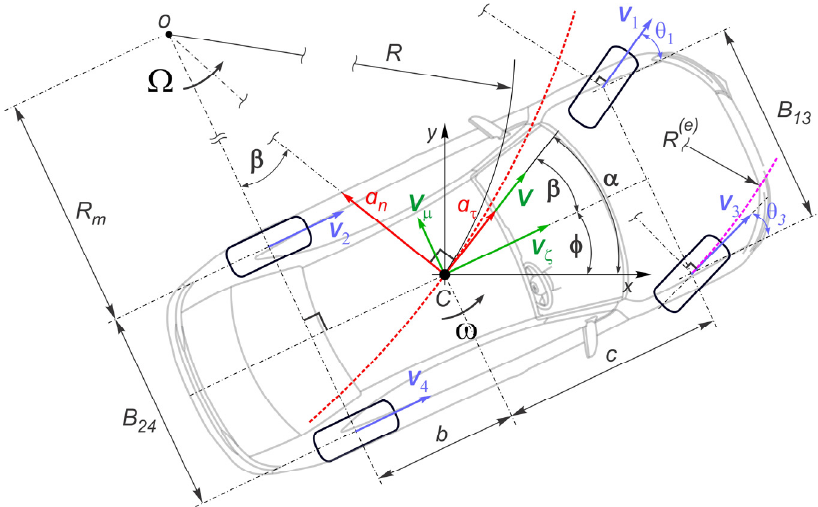
Figure 4. Relations between the mass center’s trajectory and the vehicle kinematics.